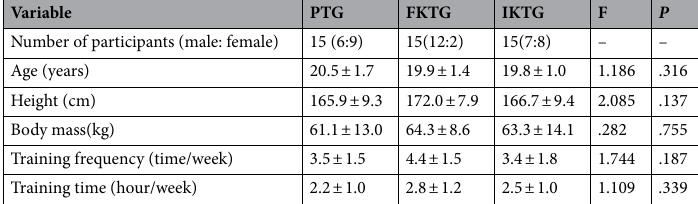
Table 7. Mean ± SD of demographic characteristics of